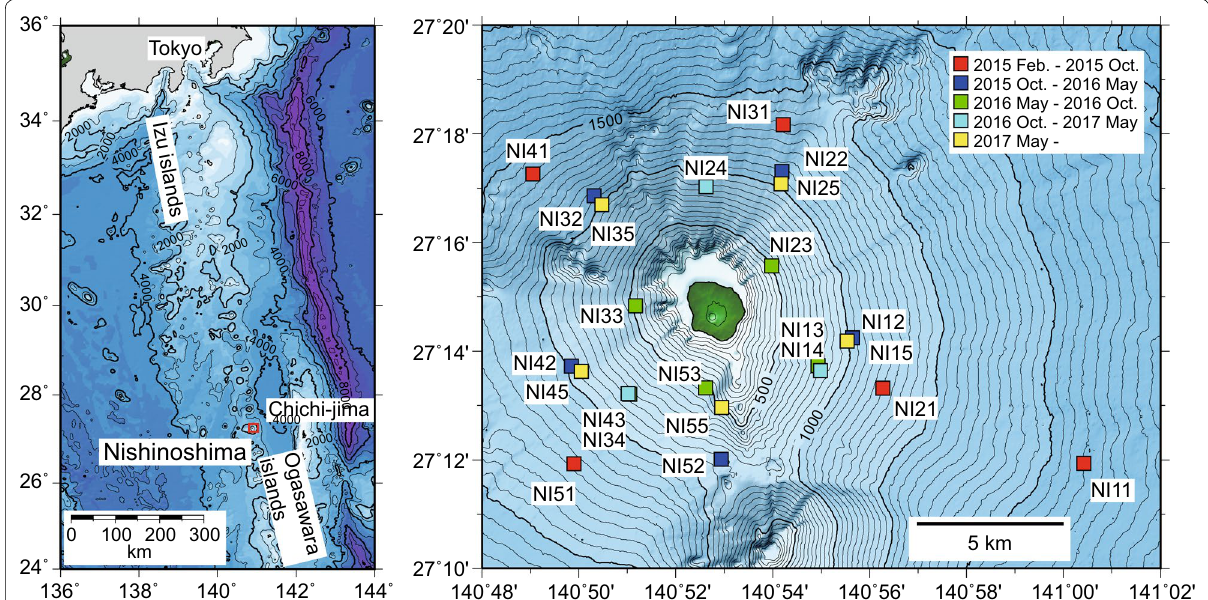
Fig. 1 Index map of Nishinoshima (left) and positions of LT-OBSs around Nishinoshima (right). Left: Nishinoshima is part of the Izu-Ogasawara volcanic arc system and is positioned approximately 1000 km south of Tokyo. Right: squares indicate positions of LT-OBSs, deployed from February 2015 to May 2017. Observations were divided into four terms, which are classified in terms of colors. Bathymetry was obtained by JCG (Morishita et al. 2017). Contour intervals for bathymetry is 20